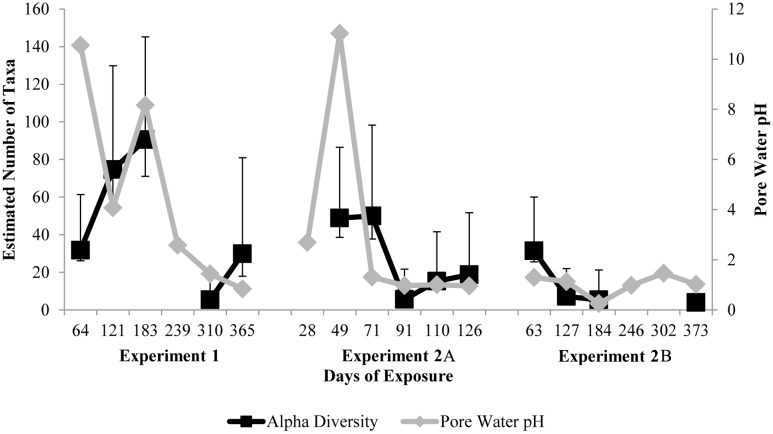
Estimated bacterial community α-diversity in corrosion products as judged by Chao1 using Illumina MiSeq V1V2 16S amplicon sequencing (black square) and estimated pore water pH (grey diamond) after one to twelve months of exposure in a manhole environment.Error bars indicate 95% confidence intervals for 1,000 bootstrap calculations of Chao1.